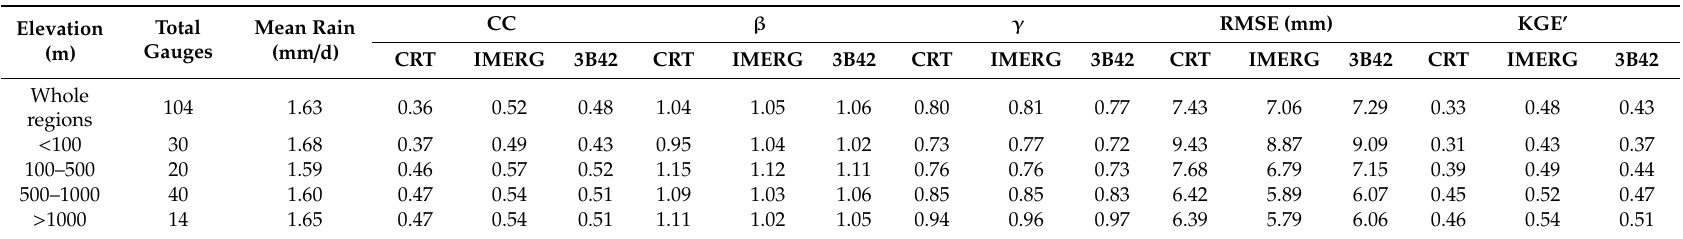
Table 3. Elevation metrics calculated between CRT, IMERG, 3B42, and rain gauge data over the whole region and for di ff erent elevation